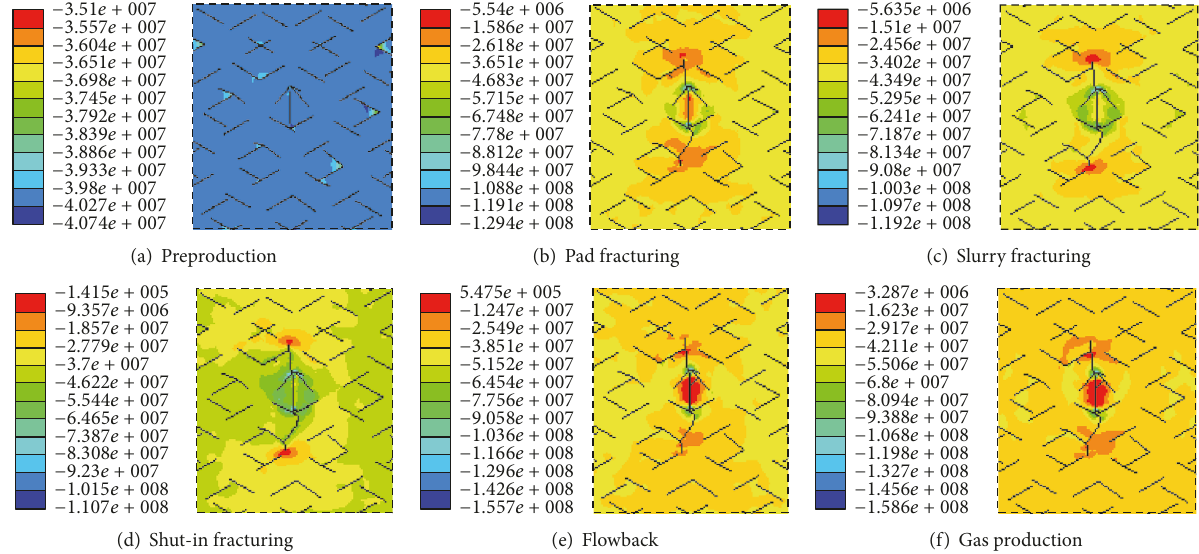
Figure 6: Dynamic propagation of cracks and first principal stress (Pa) in preproduction, fracturing, flowback, and gas production stages in naturally fractured reservoir.